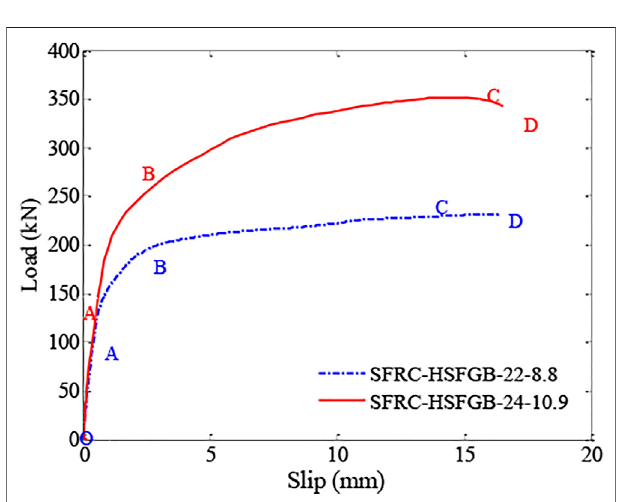
FIGURE 10 | The load-slip curves of HSFGBs in different